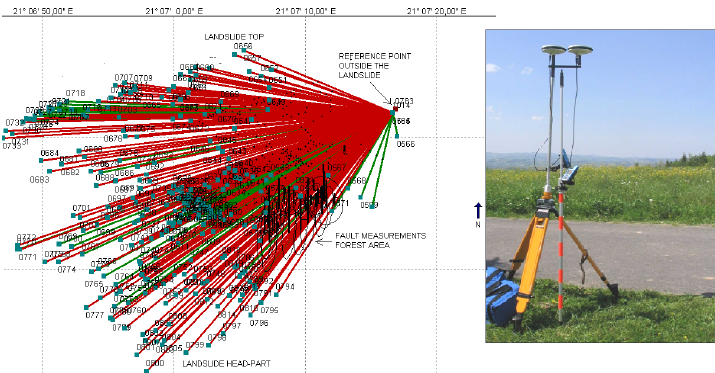
Figure 4. GPS-postprocessing results, Szymbark landslide.